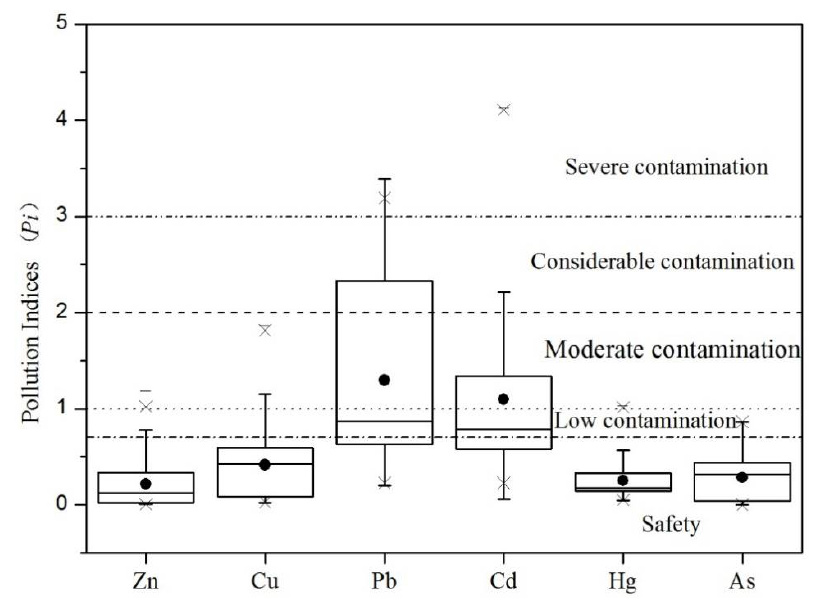
Figure 3. The Box-plots of pollution index for six toxic elements.